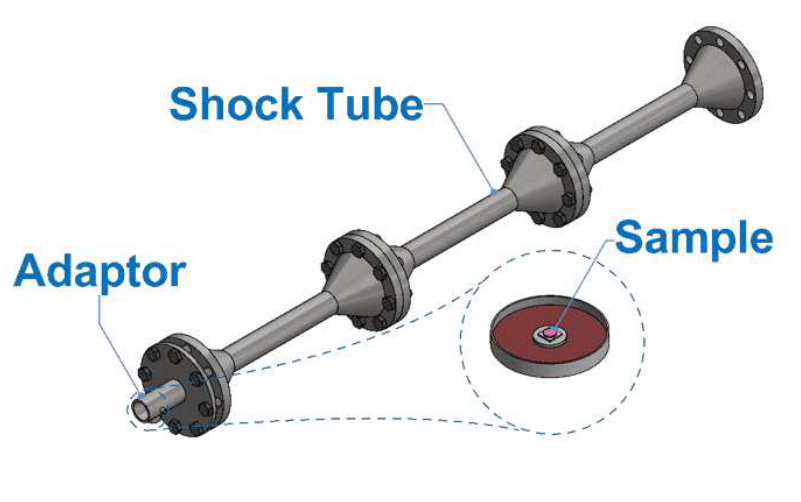
Fig. 1. Schematic image of the shock tube used in this study. It is comprised of a driving tube, a driven tube and a custom-made adaptor in which samples are held in place using a threaded screw. A shock wave resulting from the rupture of a membrane held at the interface between the driving and driven tubes propagates through the system and over the sample. A pressure sensor present in the central flanges of the driven tube monitors the wave.